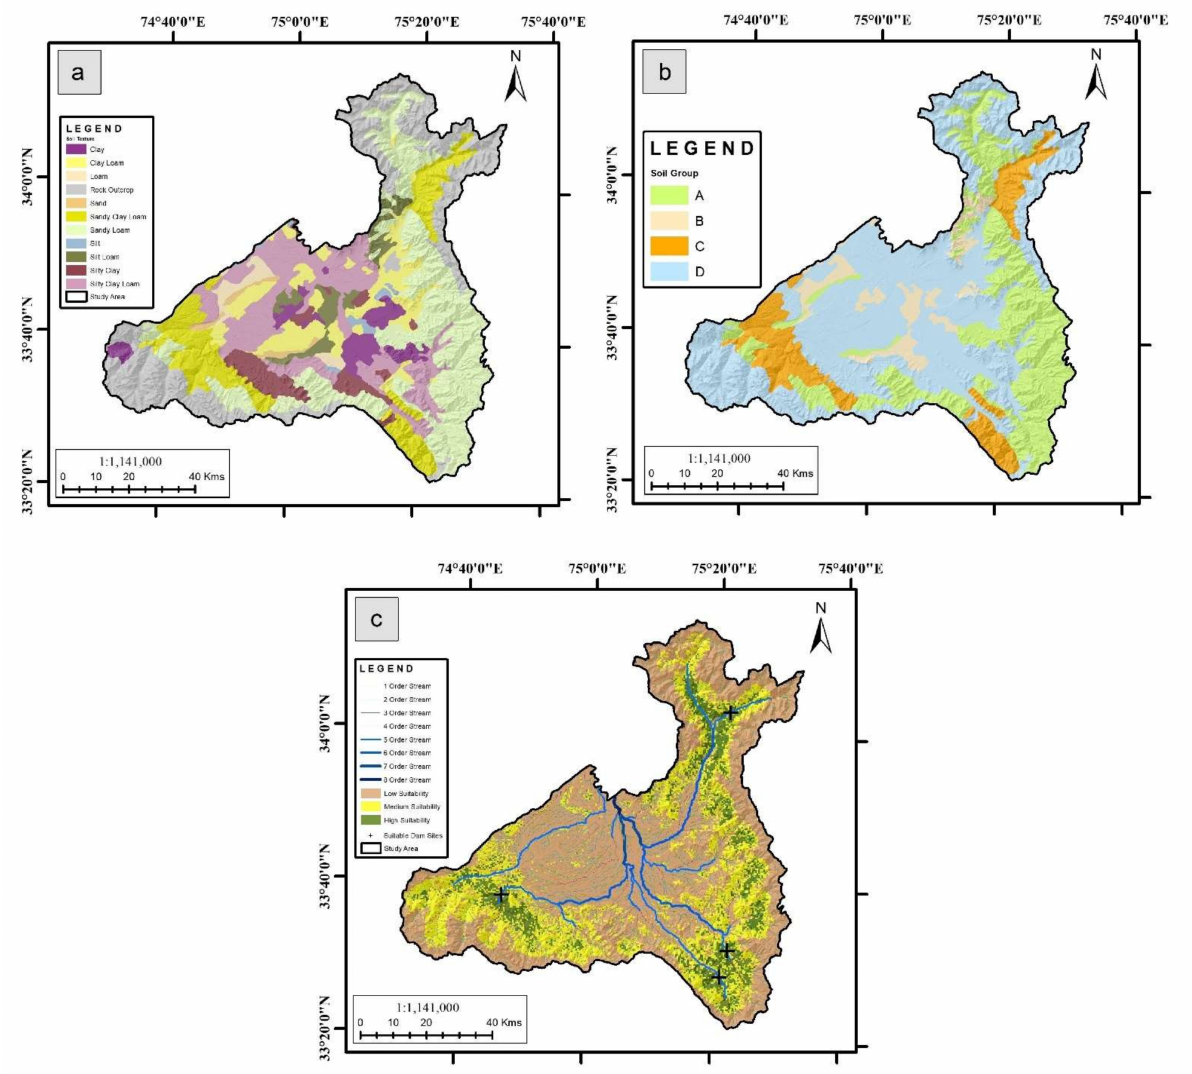
Figure 5. ( a ) Soil texture; ( b ) Soil group; ( c ) Stream order maps of the study